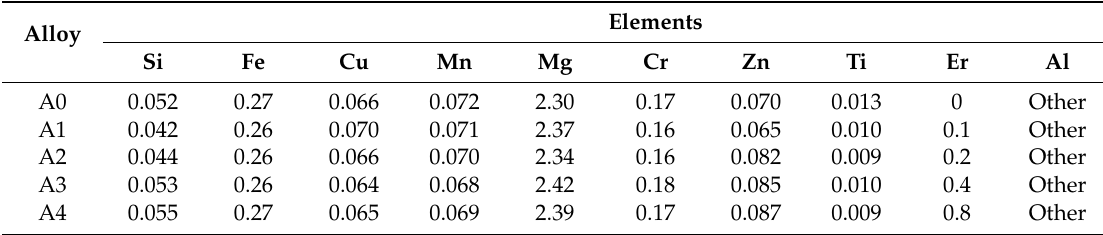
Table 1. Chemical composition of 5052 aluminum alloys (wt.